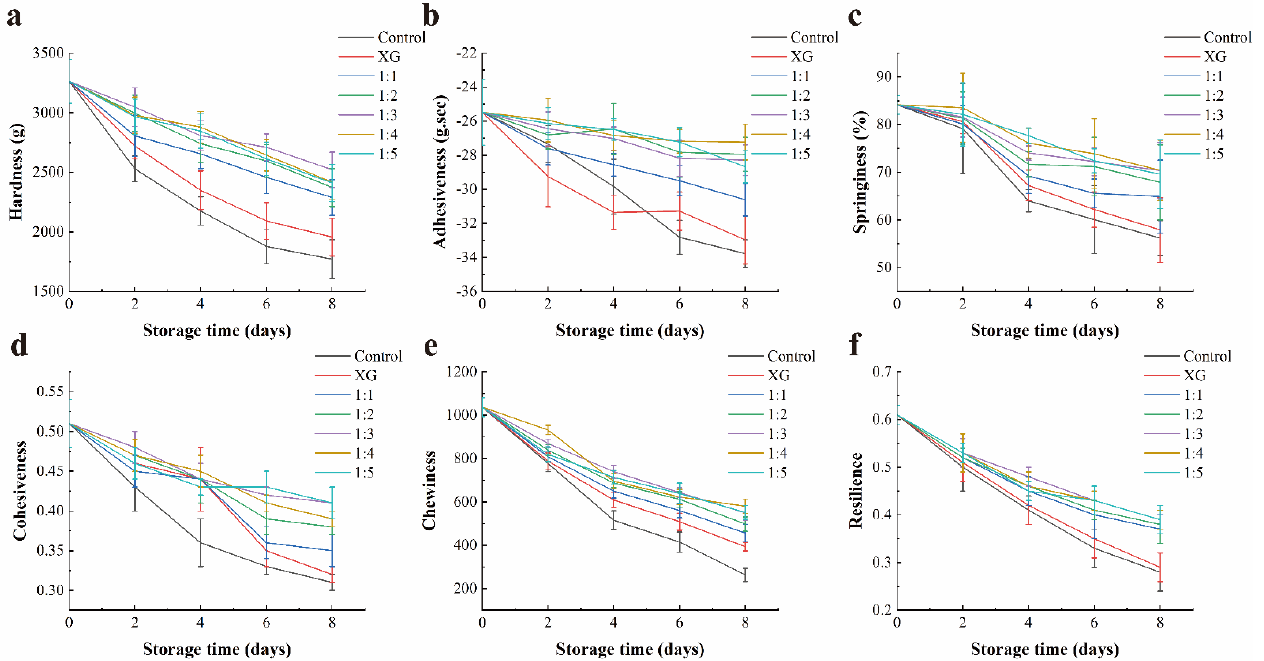
Figure 8. Changes in the texture parameter value of salmon during storage: ( a ) Hardness(g); ( b ) Adhesiveness(g.sec); ( c ) Springiness (%); ( d ) Cohesiveness; ( e ) Chewiness; ( f ) Resilience. Control = coated with distilled water; XG = coated with XG solution; 1:1 = coated with XG and liposome (1:1, v / v ) mixed solution; 1:2 = coated with XG and liposome (1:2, v / v ) mixed solution; 1:3 = coated with XG and liposome (1:3, v / v ) mixed solution; 1:4 = coated with XG and liposome (1:4, v / v ) mixed solution; 1:5 = coated with XG and liposome (1:5, v / v ) mixed solution. XG: xanthan